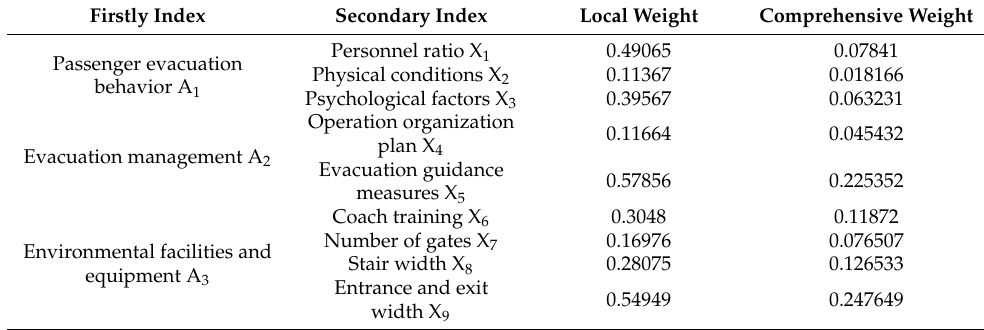
Table 2. Weights of influencing